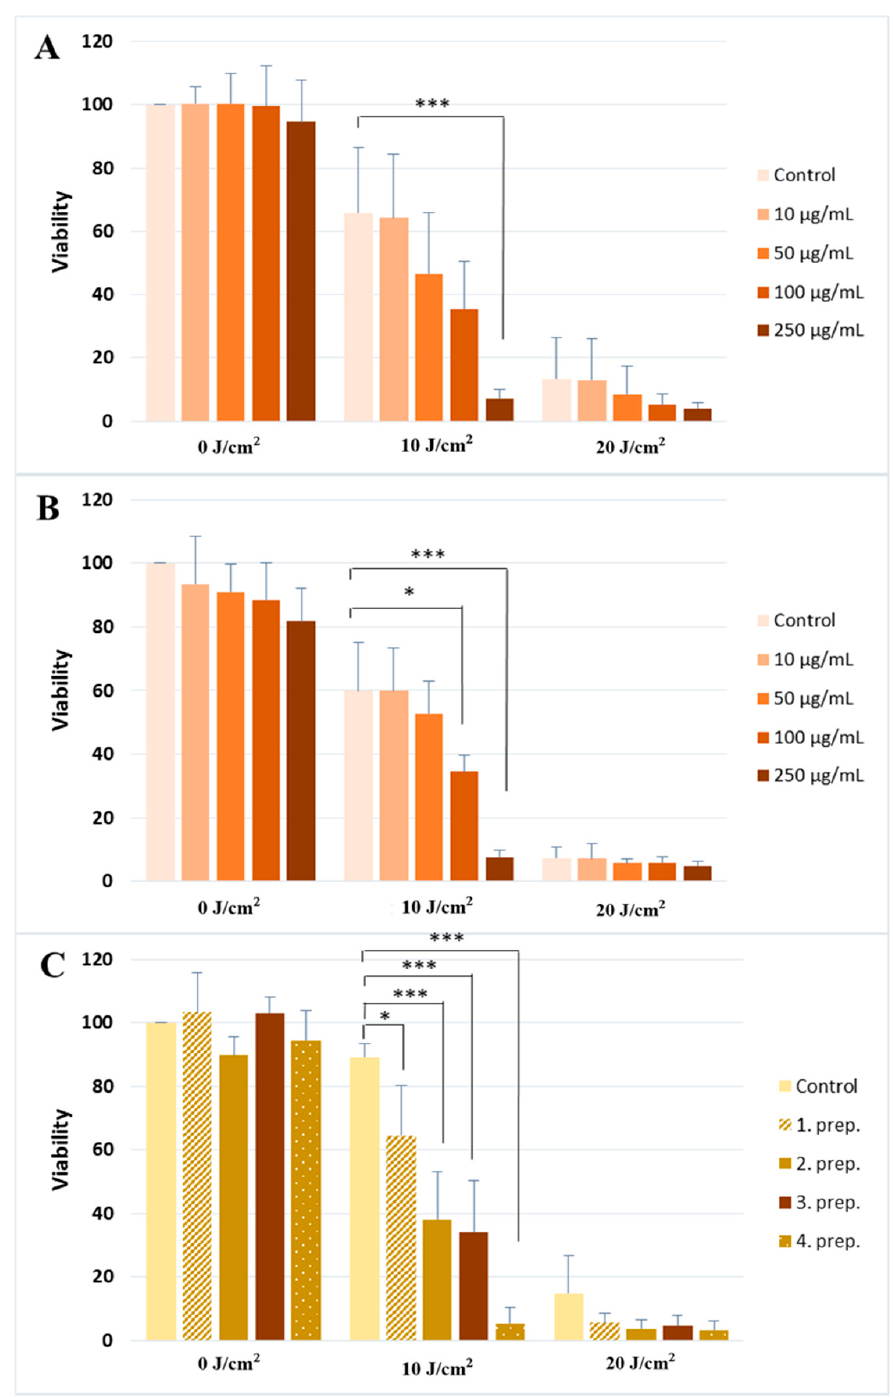
Figure 1 . UVA photosensitizing effect of different silymarin preparations. Cell viability after UVA exposure and pretreatment with ( A ) silymarin mixture (Sigma) ( B ) a commercially available silymarin compound (Silegon, Teva), and ( C ) 250 µg/mL silymarin dissolved in four different penetration-enhancers. The results are the mean of four independent experiments. Error bars represent SD; * and *** indicate statistically significant difference at p < 0.05 and p < 0.001, respectively.